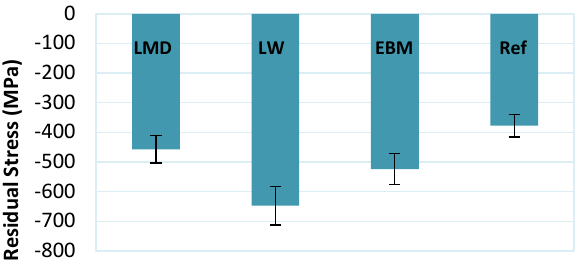
Figure 15. Residual stress measurements after machining.